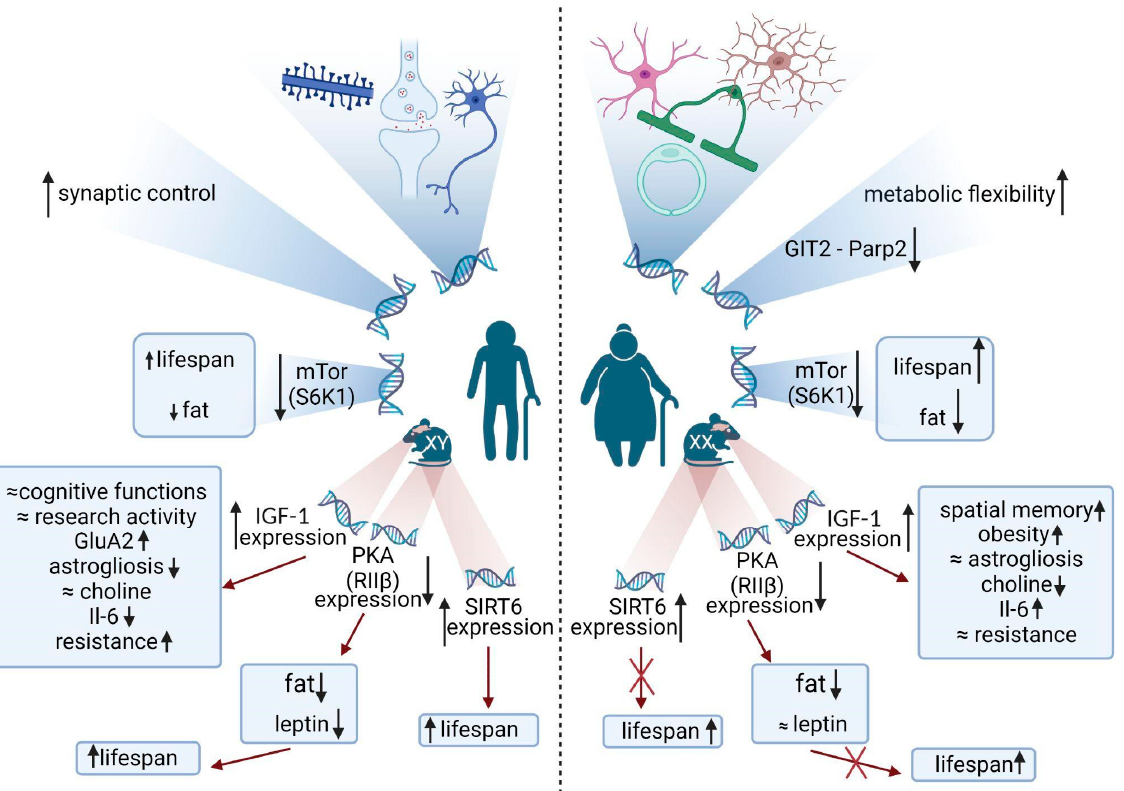
Figure 2. Sex-dependent molecular pathways associated with brain aging. During aging in males, genes associated with synapses, neurons, and dendrites are changed; however, in females, there are transcriptional changes in genes linked with microglia and astrocytes. Moreover, GIT2 gene expression changes in young age switch hypothalamus metabolic pathways that make females more resistant to metabolic changes in old age. Decreased activity through the mTor signaling pathway allows increasing lifespan more among females than males. In comparison to females in males, it is better to increase the male lifespan by decreasing the expression of RII β and increasing SIRT6 gene expression. However, some changes that are effective for prolongation of the lifespan in males are ineffective for females, for example, increased expression of the IGF-1 gene in females causes obesity, elevated IL-6 levels, and constant astrogliosis and resistance, whereas in males the same changes in IGF-1 gene expression cause an increase in GluA2 receptors and a decrease of astrogliosis and IL-6 levels with a constant value of choline. Created with